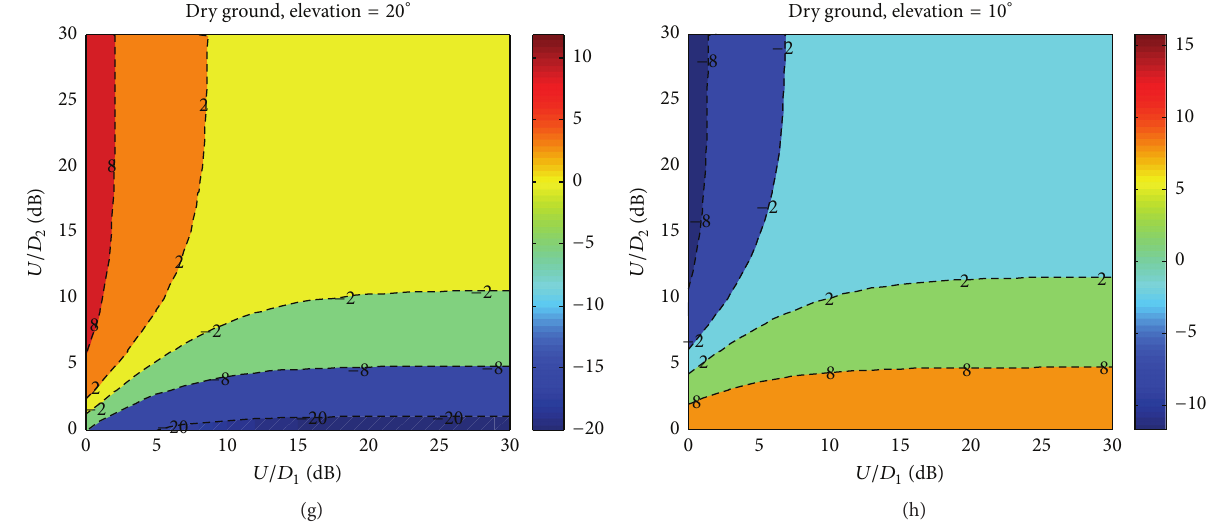
Figure 1: Effect of the multipath around dry ground on the carrier phase against 𝑈/𝐷 1 and 𝑈/𝐷 2 ratios for different elevation angles (80, 70, 60, 50, 40, 30, 20, and 10).